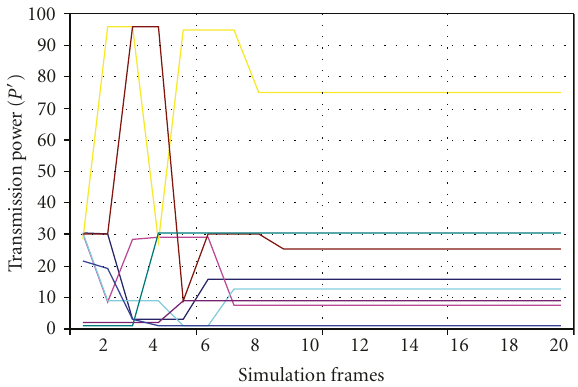
Figure 5: Convergence of SUs pairs–transmission power devoted to secondary communication.